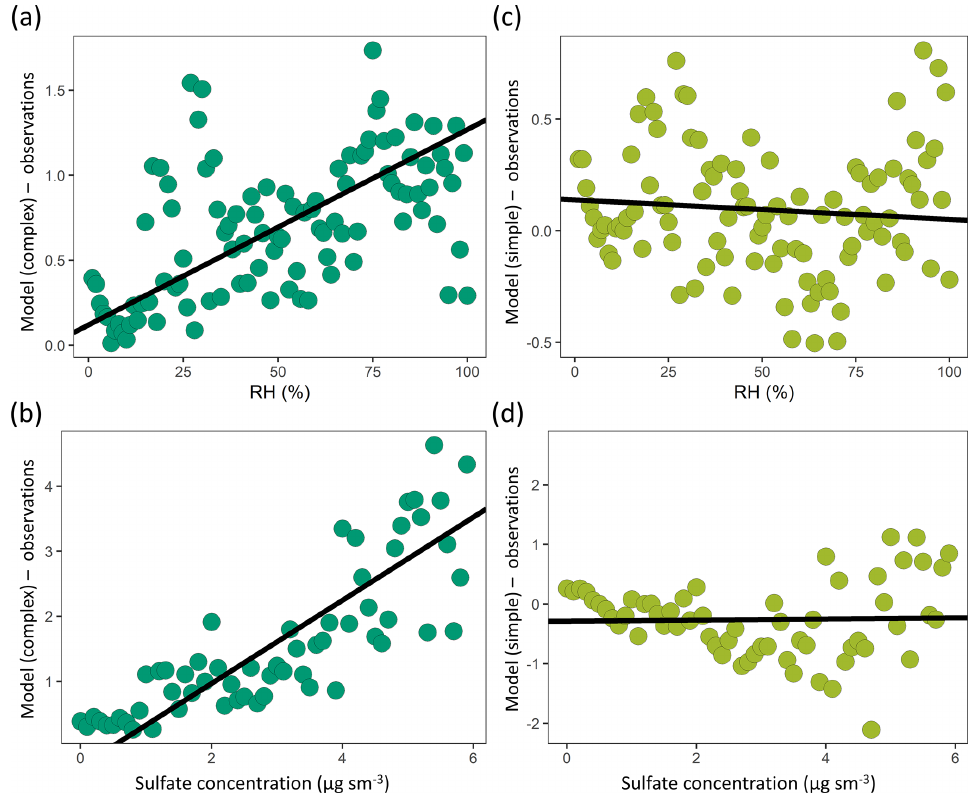
Figure 13. A comparison of model–observation OA bias and observed (a, c) relative humidity and (b, d) sulfate mass concentrations for the complex ( a, b – dark green) and simple ( c, d – light green) OA schemes across the aggregate dataset (observations are binned by intervals of 1% for RH and 0.1µgsm − 3 for sulfate). The best-fit line is shown in